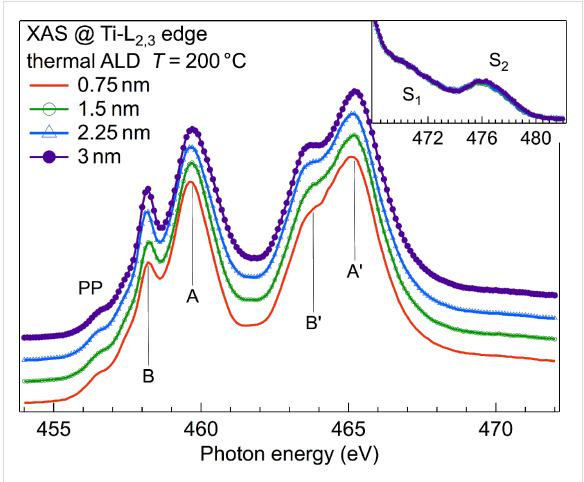
Figure 1: XAS at the Ti-L 2,3 edge measured for TiO 2 films with thick- nesses of 0.75 nm, 1.5 nm, 2.25 nm and 3 nm. Spectra were normal- ized to the same intensity at 485 eV and vertically